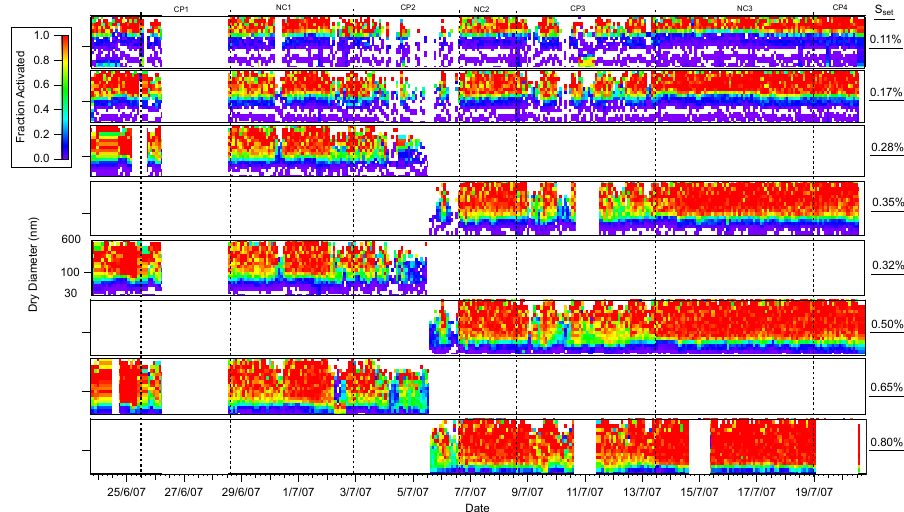
Fig. 2. Fraction of CCN activated against time, for each supersaturation setting. The fraction of aerosol activated typically increases with dry diameter and supersaturation. The decision was made during CP2 to increase the upper limit of the supersaturation setting ( S set ) from 0.65% to 0.80%, in an attempt to activate more of the aerosol below